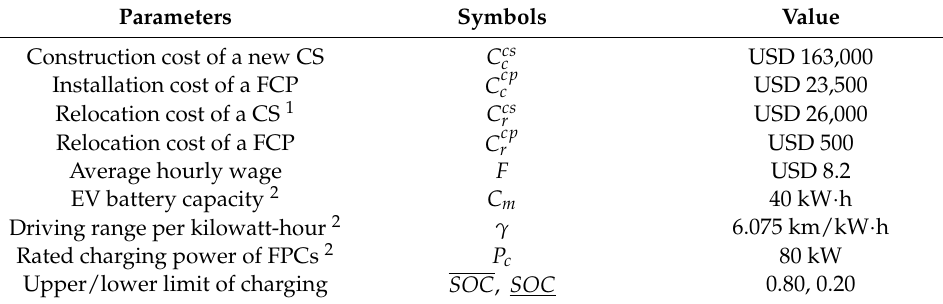
Figure 4. The spatial-temporal distribution of traffic flow and charging demand with 10,000 trajectories in a day. The data are the average of the demand points with the same kind of UFZs. It can be found that the traffic flow and charging demand fluctuate in one day. ( a ) The distribution of traffic flow; ( b ) the distribution of charging demand. Table 1. Key parameters in the optimization model.